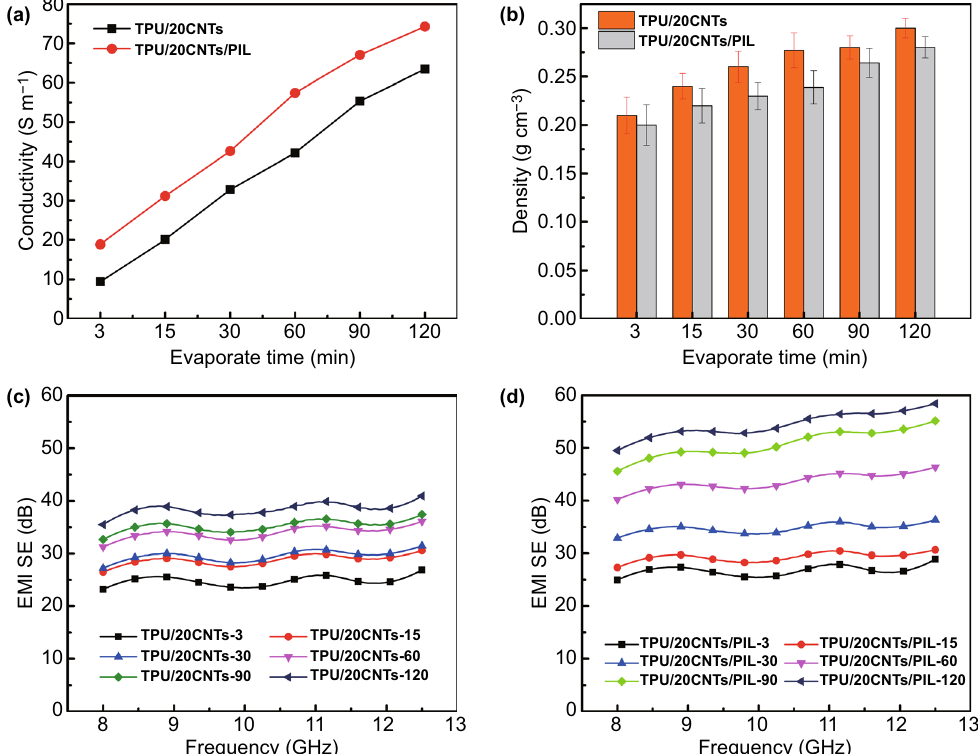
Fig. 5 Conductivity a and density b of TPU composite foams with different evaporate time; c and d EMI SE of TPU composite